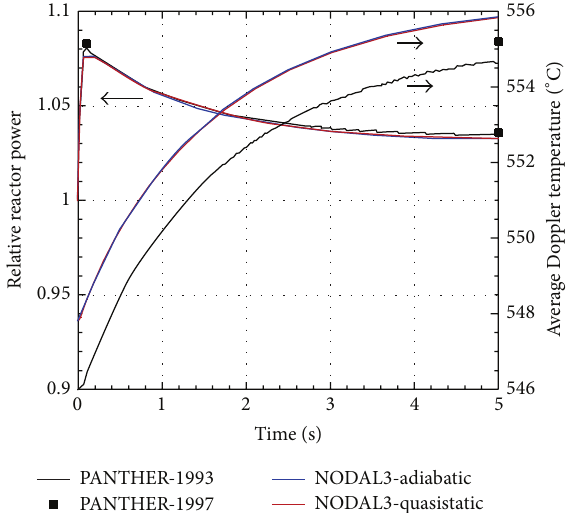
Figure 9: Comparison between NODAL3 and references results for case